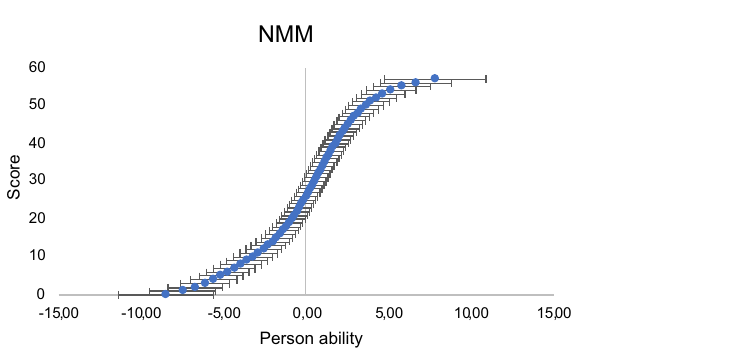
Figure 3. Observed S-curve correlating observed responses (raw score on the y-axis = 57) with the Rasch- estimated person ability for the NMM (x-axis). Measurement uncertainties with coverage factor k =